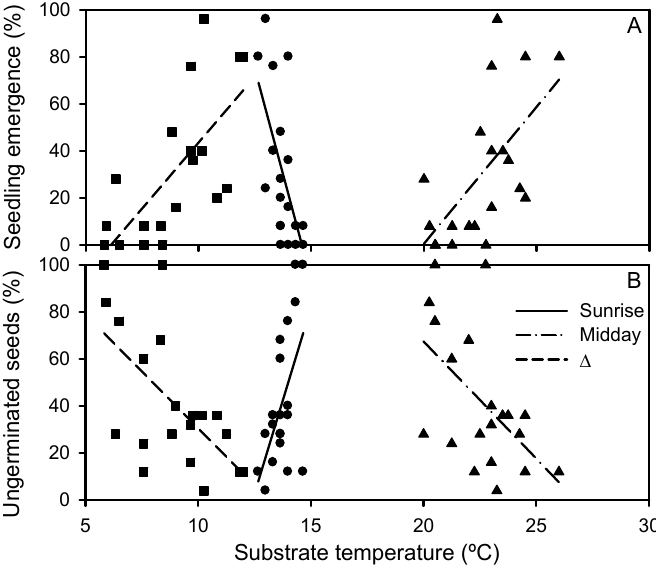
Figure 3. Relationships between the percentages of ( A ) seedling emergence and ( B ) non-decomposing ungerminated seeds of Iris pseudacorus with substrate temperatures at sunrise ( ∂ ) and midday ( ▲ ) and the difference ( ∆ ) between midday and sunrise temperatures ( (cid:4) ). Regression equations: ( A ) Sunrise Tª, y = 522.520 − 35.805x, R 2 = 0.392, p = 0.003, and n = 20; Midday Tª, y = − 232.141 + 11.635x, R 2 = 0.377, p = 0.004, and n = 20; ∆ Tª, y = − 68.519 + 11.201x, R 2 = 0.485, p = 0.001, and n = 20; ( B ) Sunrise Tª, y = − 391.837 + 31.561x, R 2 = 0.328, p = 0.010, and n = 20; Midday Tª, y = 266.783 − 9.964x, R 2 = 0.298, p = 0.013, and n = 20; ∆ Tª, y = 127.286 − 9.664x, R 2 = 0.390, p = 0.003, and n =